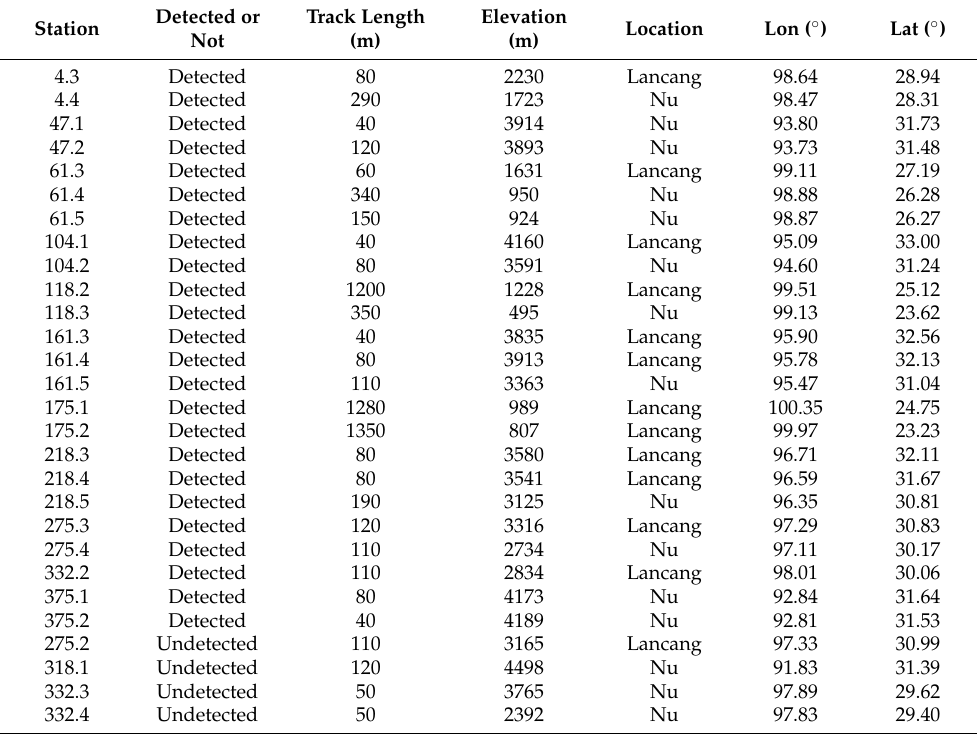
Table A3. Information on virtual stations in S3B for this study, including station number, track length (estimated from Google Earth), elevation (estimated from ALOS), and coordinates.